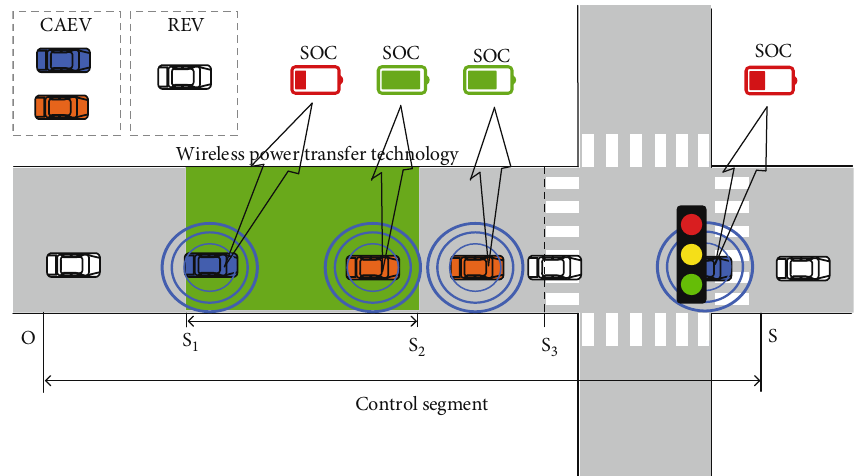
Figure 1: The scenario with di ff erentiated driving strategy at the signalized intersection with the DWPT.